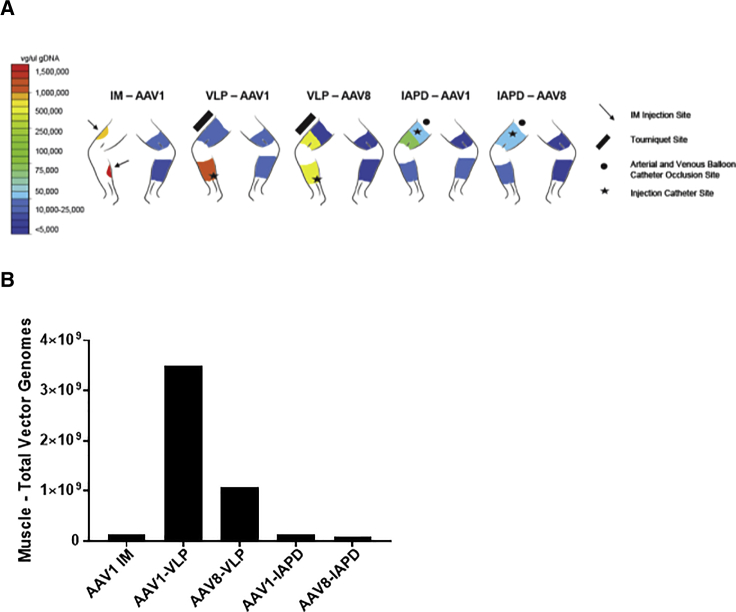
Vector Distribution in the Muscle and Estimated Total Vector Genomes in the Lower Extremity(A) Heatmap of distribution of vector genomes in the muscle of both the dosed and undosed limbs 60 days post-delivery. IM, intramuscular; IAPD, intra-arterial push and dwell; VLP, venous limb perfusion. n = 2 per group. (B) Total vector genomes delivered to the targeted rhesus lower extremity muscle, as estimated based on the volume of muscle tissue perfused and the nuclear density of muscle tissue.